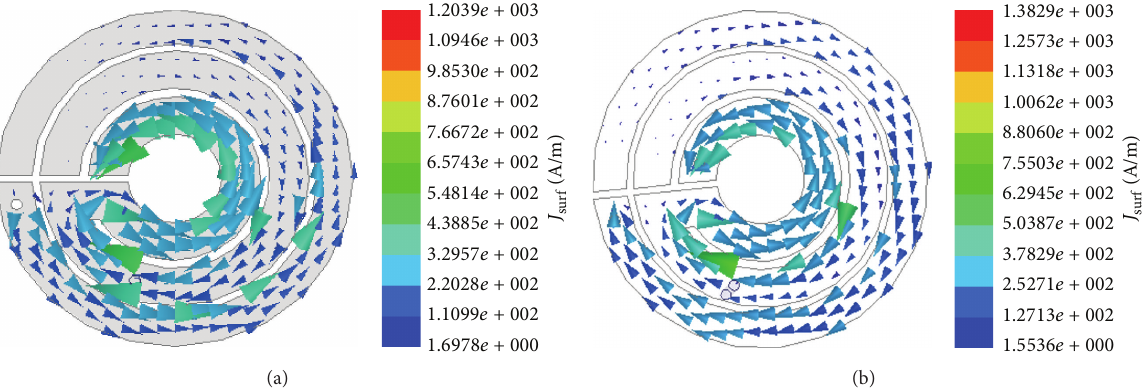
Figure 3: Current distributions at (a) 387 MHz and (b) 413MHz.